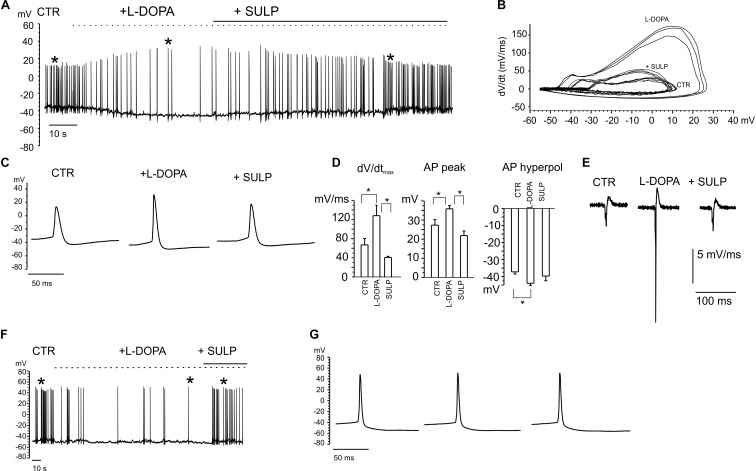
Current-clamp recordings exhibiting the features of L-DOPA induced modulation of neuronal firing. (A) Repetitive firing activity is inhibited by L-DOPA (20 μM) and restored by blocking the D2 autocrine receptors. Firing inhibition is accompanied by a membrane hyperpolarization and increased peak amplitude. (B) Phase-plane plot analysis of the action potential shown in (A). (C) Signals identified by the asterisk in (A) are shown through an enlarge scale. (D) The following parameters have been calculated from the phase-plot analysis: maximum dV/dt versus V, action potential (AP) peak amplitude, AP hyperpolarization peak. Data are expressed as mean values. Statistical difference (∗p < 0.05) is indicated on the bar histogram. (E) Negative first derivative of signals reported in (C). (F) Example of firing inhibited by L-DOPA without significant alterations in the AP peak amplitude, shown in (G) on an enlarged scale.